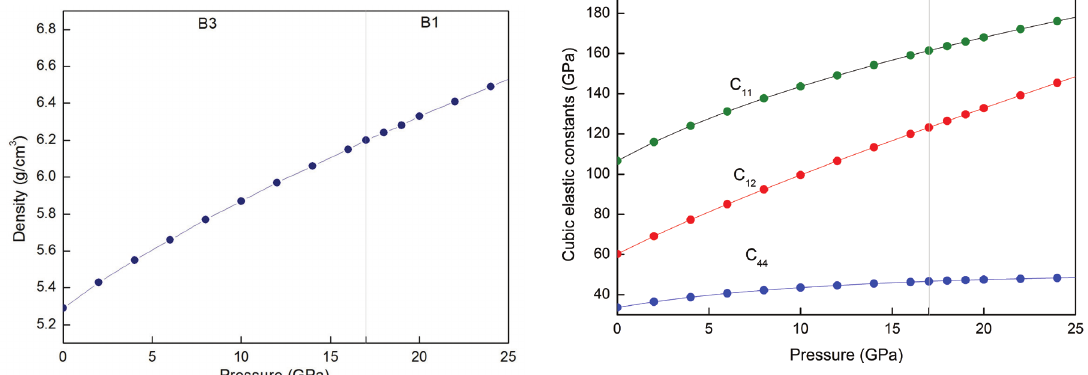
, C and C of GaAs 11 12 44